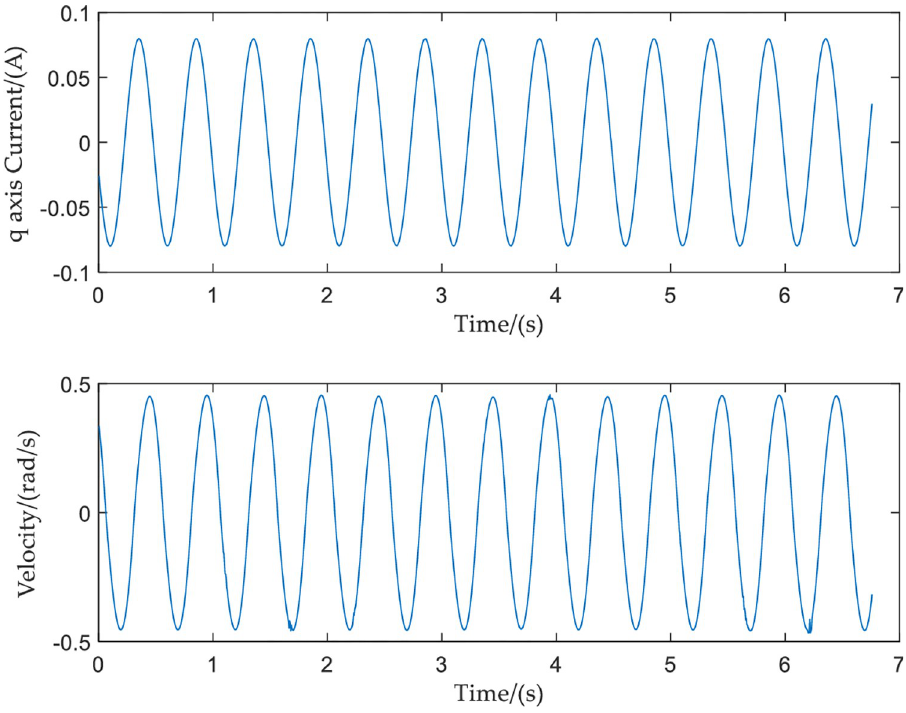
Fig 10. Single frequency input and output